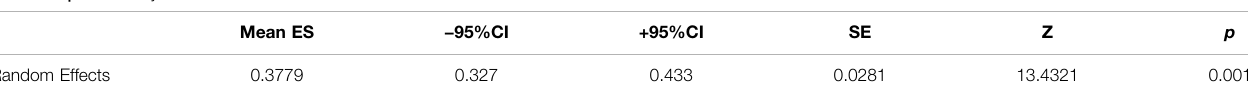
TABLE 1 | Meta analytic results.